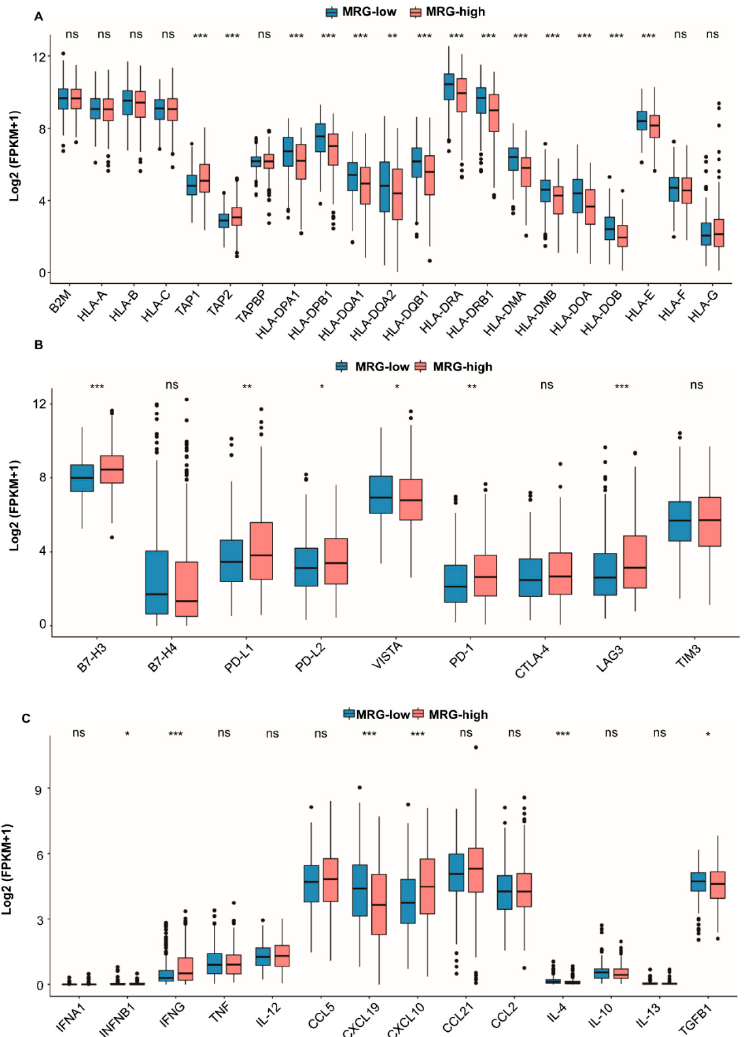
Figure 4. Expression of immunomodulators in different MRG subgroups from TCGA cohort ( n = 500). ( A ) Major histocompatibility complex (MHC) molecules expression patterns in different MRG subgroups. Significant statistical differences between the two subgroups were assessed using the Wilcoxon test (ns, not significant; **, p < 0.01; ***, p < 0.001). ( B ) Inhibitory immune checkpoints molecules expression patterns in both MRG subgroups. Significant statistical differences between the two subgroups were assessed using the Wilcoxon test (ns, not significant; * p < 0.05; ** p < 0.01; *** p < 0.001). ( C ) Cytokine expression patterns in both MRG subgroups. Significant statistical differences between the two subgroups were assessed using the Wilcoxon test (ns, not significant; * p < 0.05; *** p < 0.001).